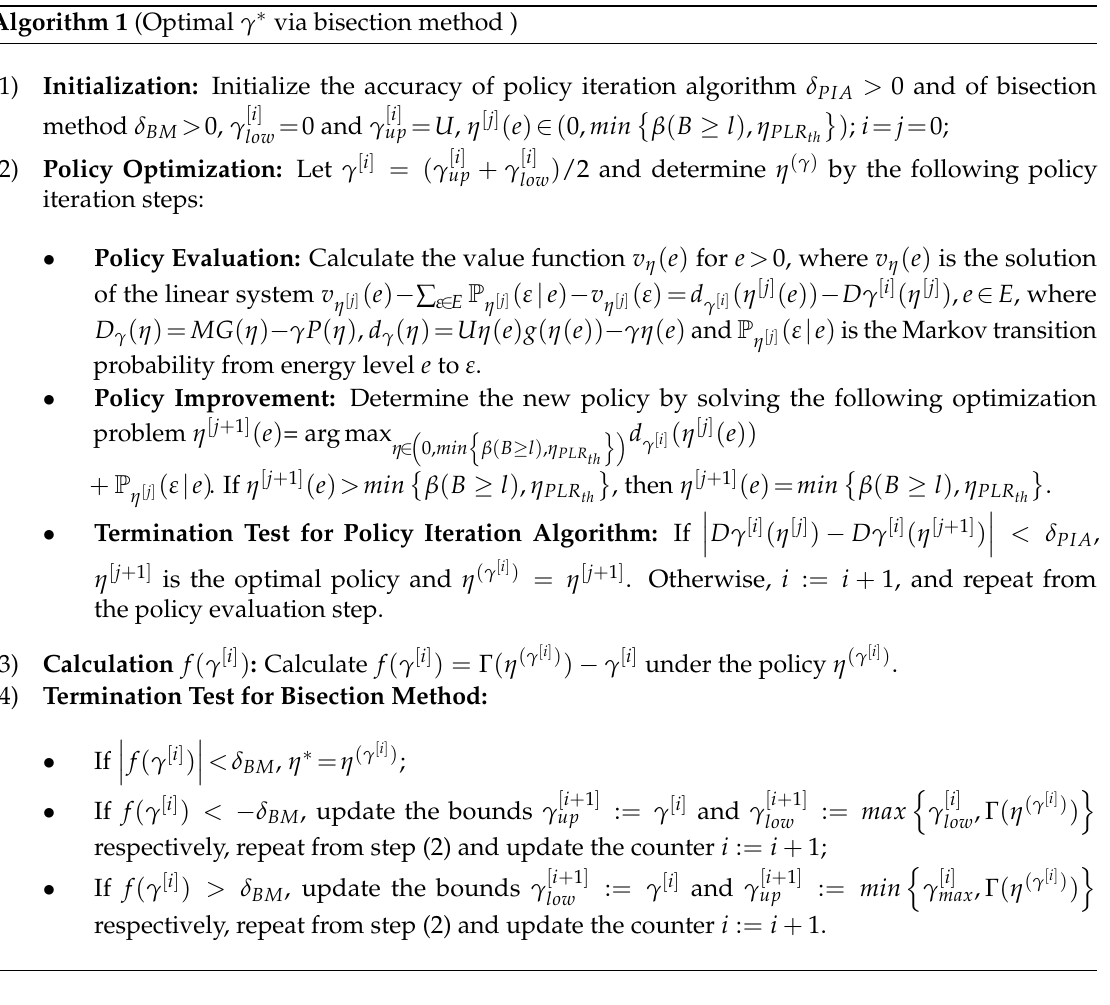
Algorithm 1 (Optimal γ ∗ via bisection method